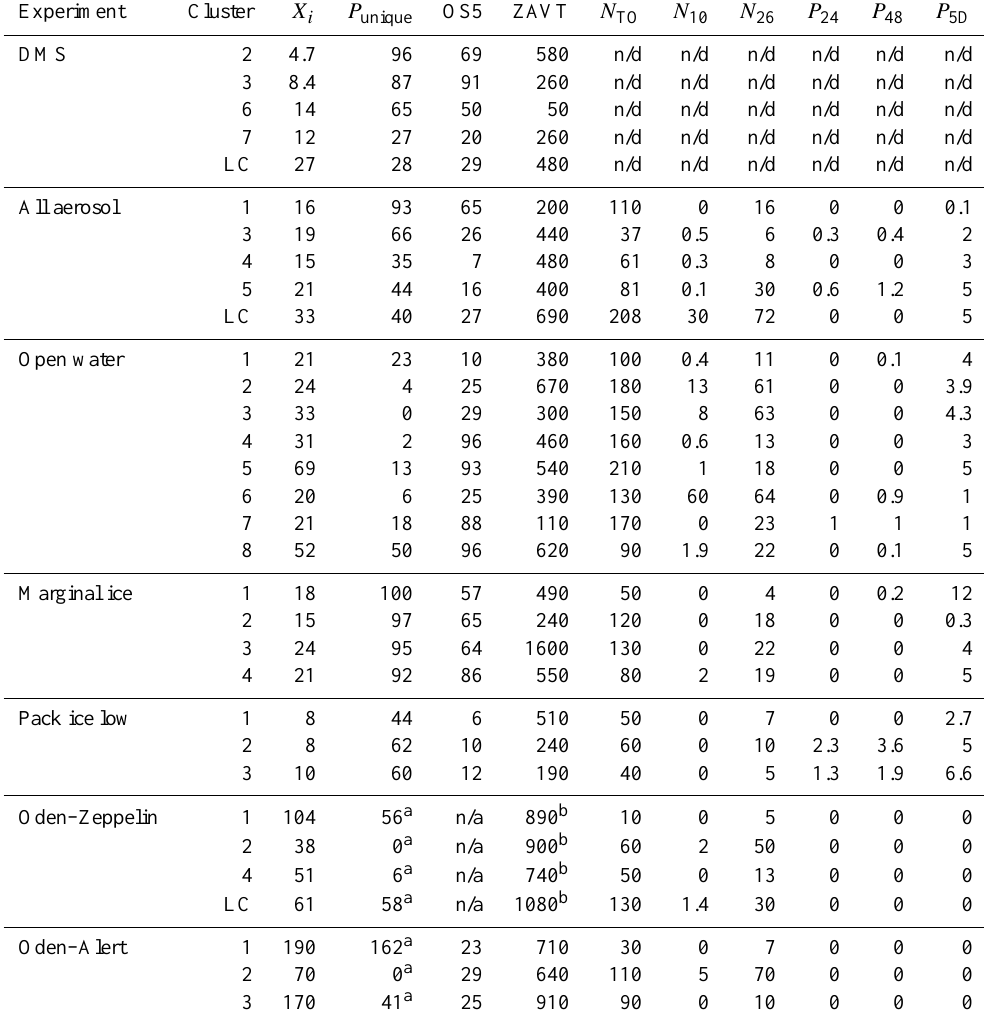
Table 3. Key data of the clusters of the cluster experiments. LC is longitudinal cluster (see Sect. 3). X i is the width of geographic coverage (see Eq. 4); P unique is the parameter of the uniqueness of geographic coverage (%, see Sect. 3); ZAVT is the average height of trajectories during the last 5 days before arrival at Oden ; OS5 is the cluster-median open water (%) under the back trajectories during the last 5 days before arrival at Oden ; N TO is the cluster-median total particle number concentration (cm − 3 ) ; N 10 is the cluster-median particle number concentration below 10nm diameter (cm − 3 ) ; N 26 is the cluster-median particle number concentration below 26nm diameter (cm − 3 ) ; P 24 is the median sum of precipitation along the last 24h along the trajectories; P 48 is the median sum of precipitation along the last 48h along the trajectories; P 5D is the median sum of precipitation along the last 5 days along the trajectories; n/a is non applicable; n/d is no data. Aerosol and gas values for experiment Oden–Zeppelin hold for Oden data